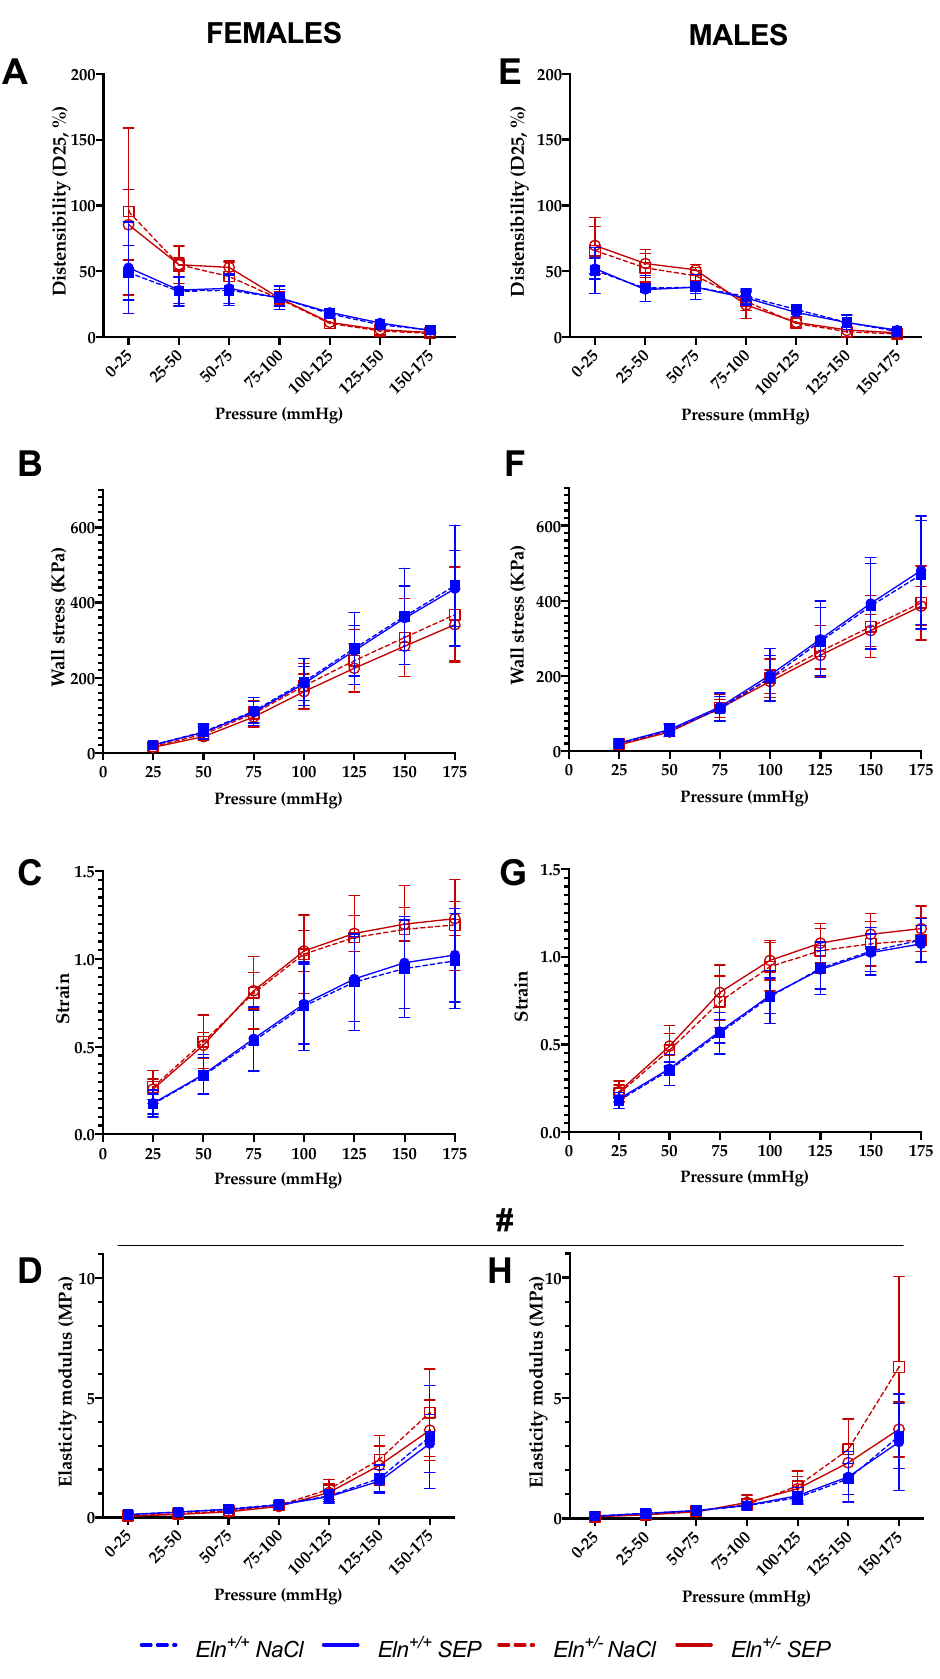
Figure 3. Mechanical parameters of the cannulated ascending aorta. The measurements were performed by pressure arteriography 3 days after NaCl (control) or SEP intravenous injection in